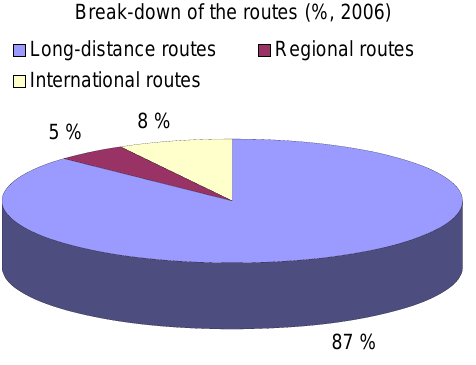
Fig 2. The distribution of routes in the Riga International Coach